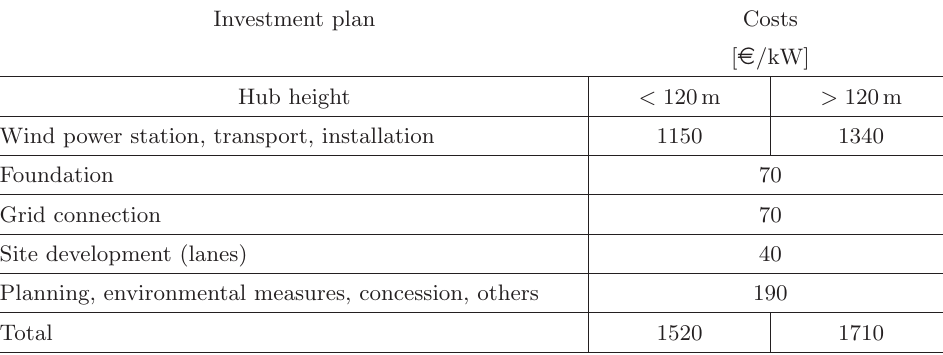
Table III. – The typical investment costs of a 2 MW onshore wind power station in Germany (Status: 2013). Data taken from WindGuard GmbH, Germany.